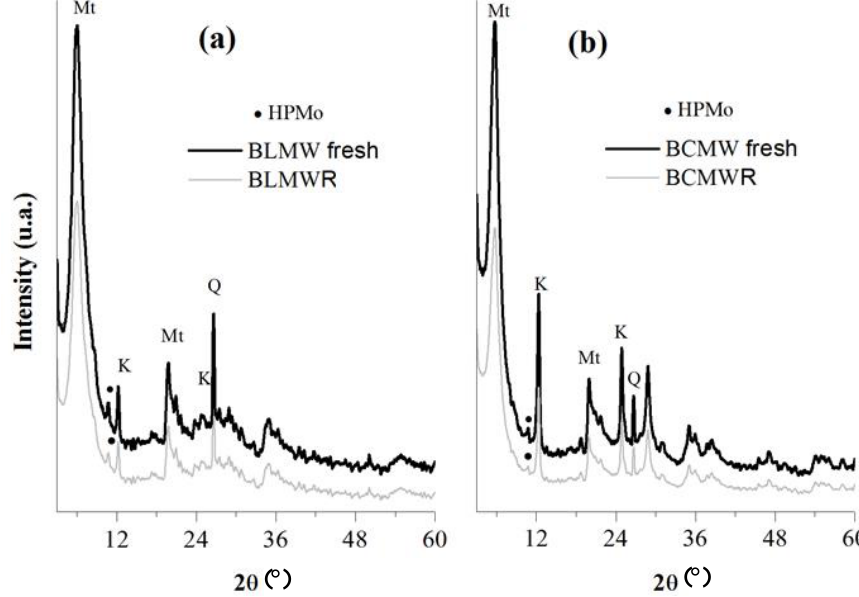
Figure 14. X-ray diffractograms of the samples fresh (BLMW and BCMW) and reused (BLMWR and Figure 14. X-ray di ff ractograms of the samples fresh (BLMW and BCMW) and reused (BLMWR and BCMWR) catalysts. ( a ) BLMW fresh, BLMWR; ( b ) BCMW fresh, BCMWR. BCMWR) catalysts. ( a ) BLMW fresh, BLMWR; ( b ) BCMW fresh,